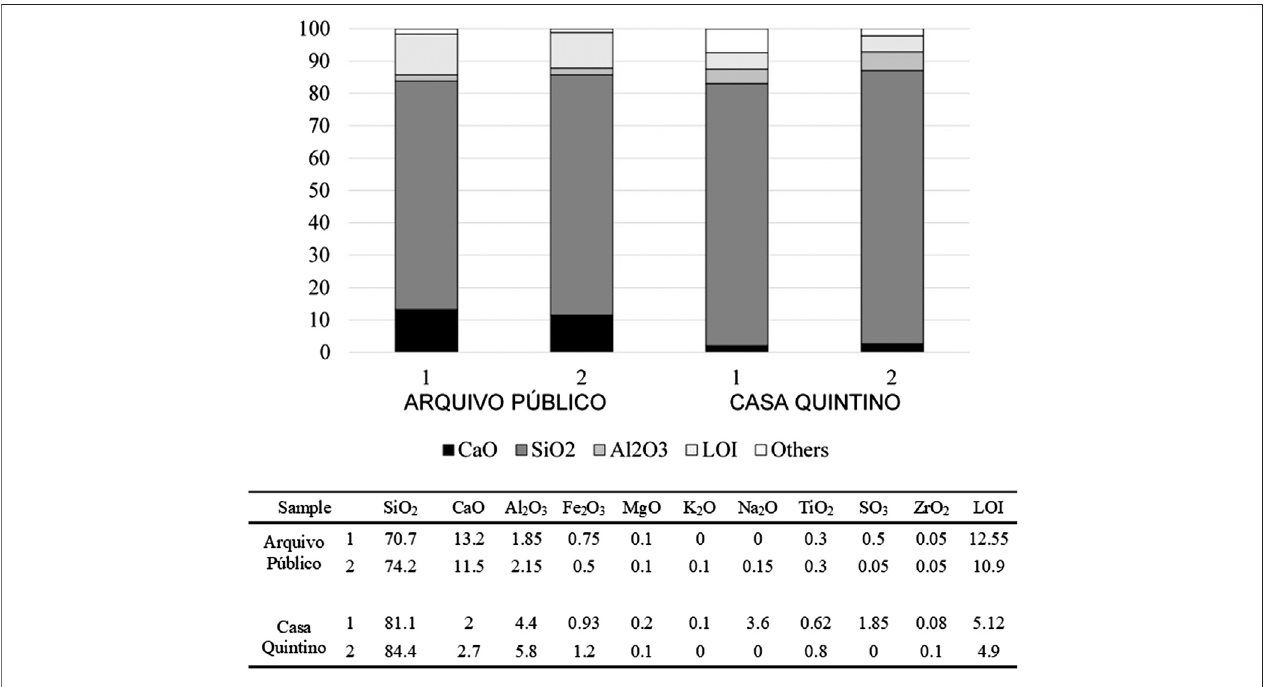
FIGURE 5 | Percentage of major and minor elements present in the samples.